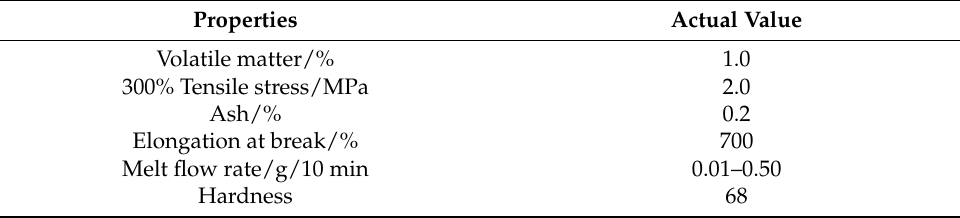
Table 2. Properties of SBS.